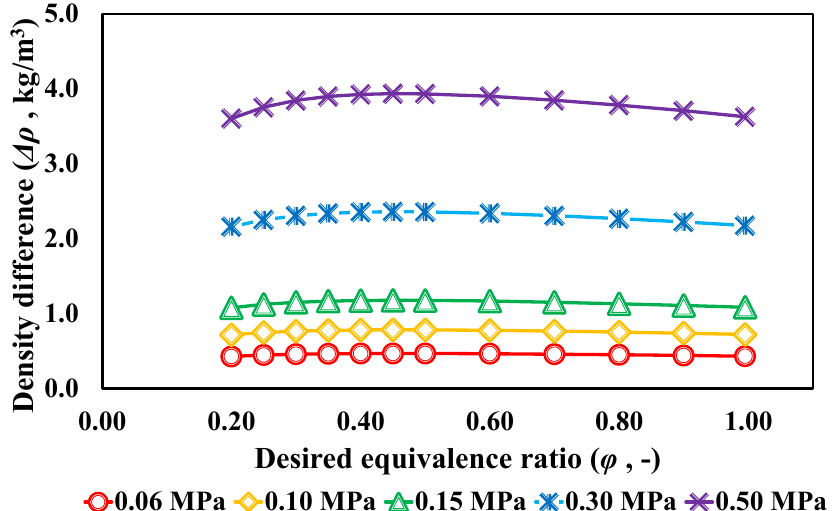
Figure 10. Density difference of hydrogen-air premixed flames with equivalence ratio under different initial